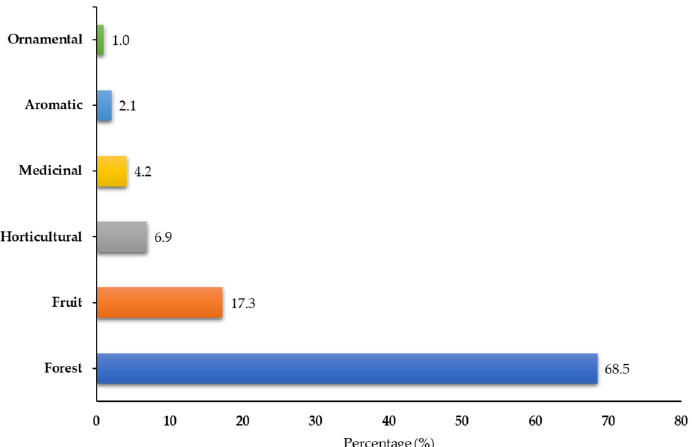
Figure 5. Main groups of plant species for which the Dickson Quality Index has been used as a quality indicator. A representative and random sample of 289 articles was extracted from a total sample of articles of n = 662. Data were retrieved from the Scopus database 2020.